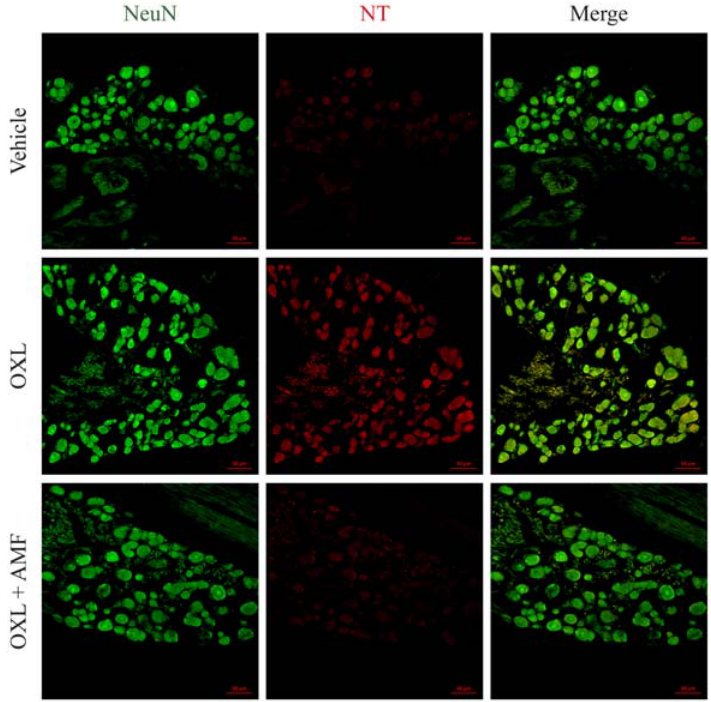
Figure 4. Nitrotyrosine (NT) expression in the dorsal root ganglia on the 28th experimental day. Green: neuronal marker (NeuN); red: nitrotyrosine; merge: yellow. Magni fi cation 200 (cid:1) , scale bar 50 m m. OXL: oxaliplatin; AMF: amifostine.